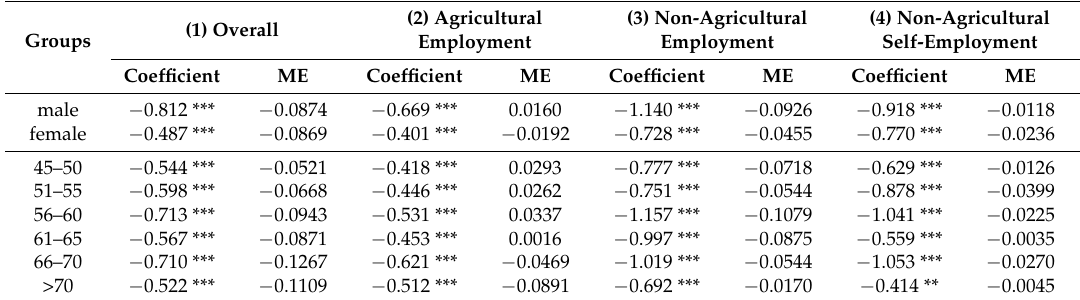
Table 4. The gender and age differences of health impaction of LFP.